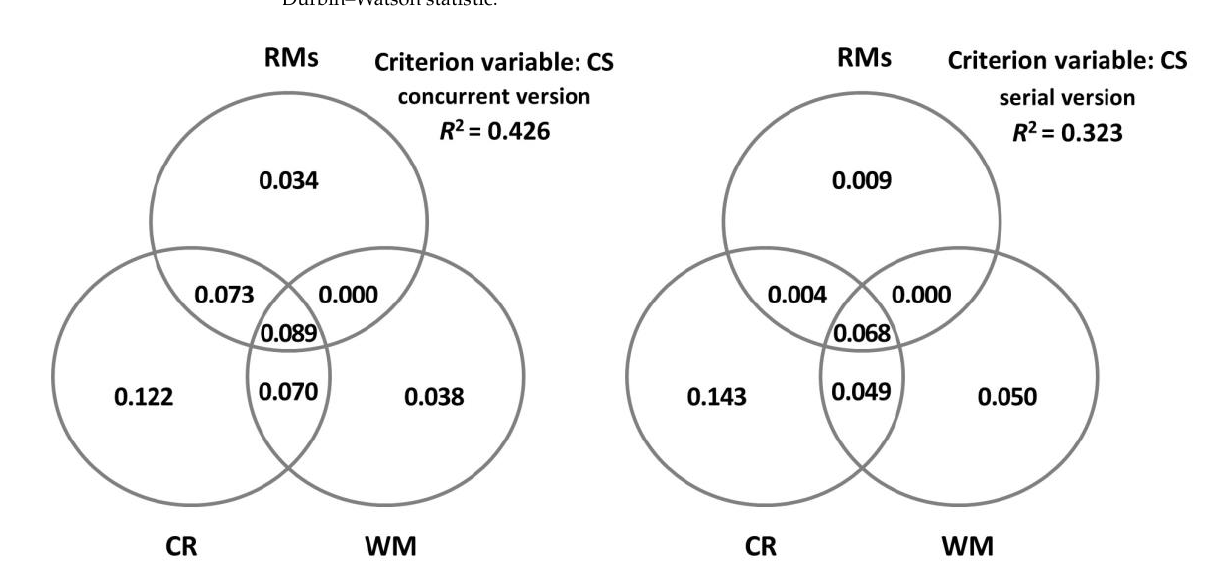
Figure 3. Decomposition of the variance in canonical sentences (CSs) explained jointly and uniquely by cognitive reserve (CR), measured by the cognitive reserve questionnaire (CRQ); working memory (WM), measured by the digit ordering task (DO); and the rest of the measures (RMs: age, MMSE, GDS-15, and MFE). Figure 4. Decomposition of the variance in noncanonical sentences (NoCS) explained jointly and uniquely by cognitive reserve (CR), measured by the cognitive reserve questionnaire (CRQ); work- ing memory (WM), measured by the digit ordering task (DO); and the rest of the measures (RMs: age, MMSE, GDS-15, and MFE). Moreover, on propositional density, CR alone explained the performance in both concurrent and serial versions of the task for 1PS (Table 7). Conversely, for 2PS, both CR and WM explained the performance in both versions (Table 8). The only difference be- tween the concurrent and serial versions in 2PS was the relative weight of both variables, with a higher weight of CR in the concurrent version and a higher weight of WM in the